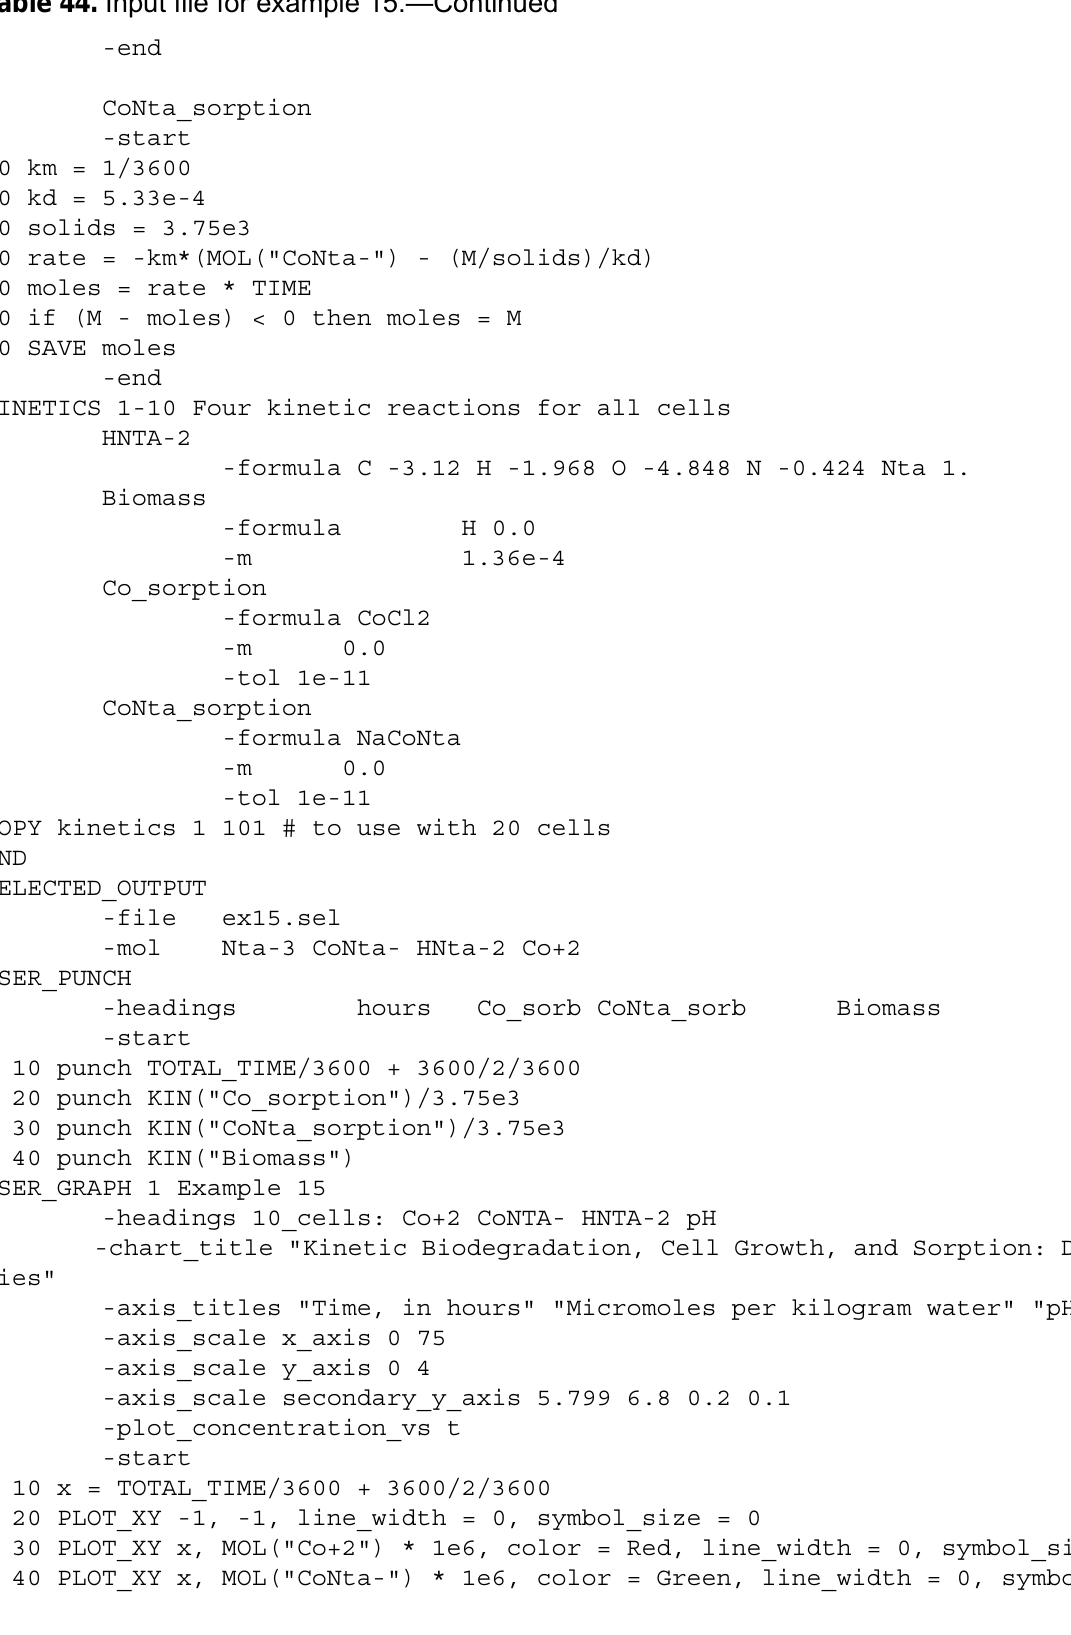
Table 44. Input file for example